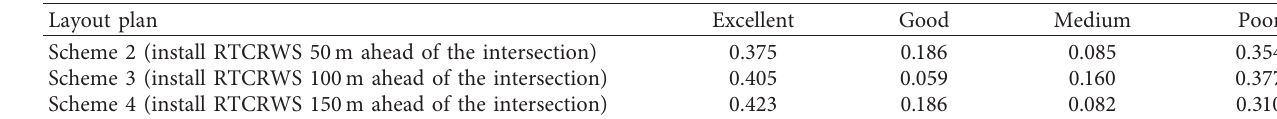
Figure 6: Comprehensive evaluation results of three Table 6: Results of fuzzy synthesis evaluation.